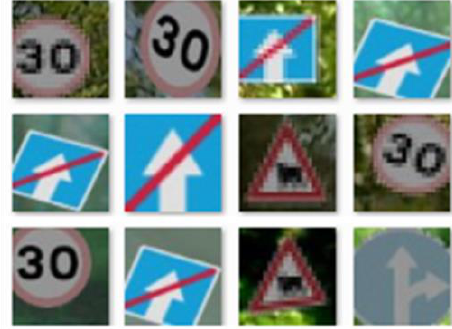
Figure 2: Examples of synthetically generated